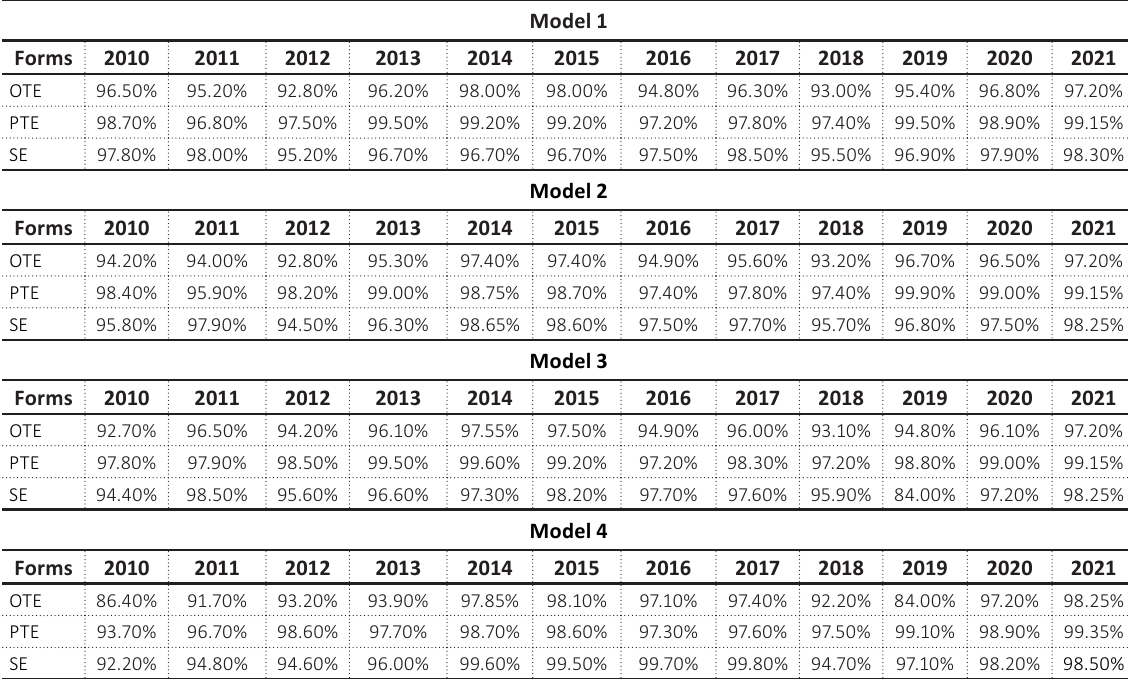
Table 5. Annual evolution of efficiency scores per category